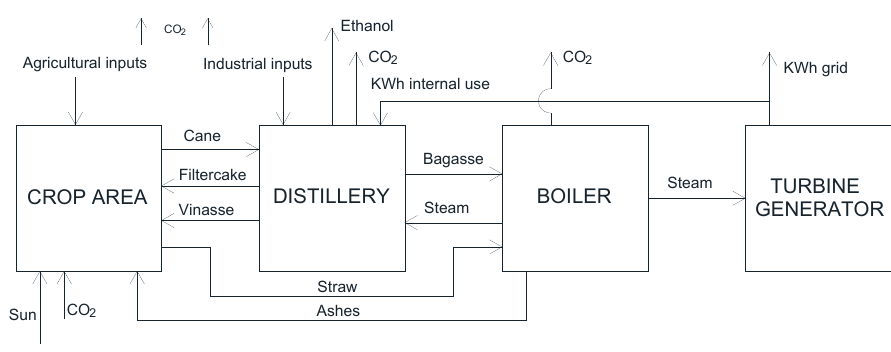
Figure 1. General flowchart of the process (mass and energy).